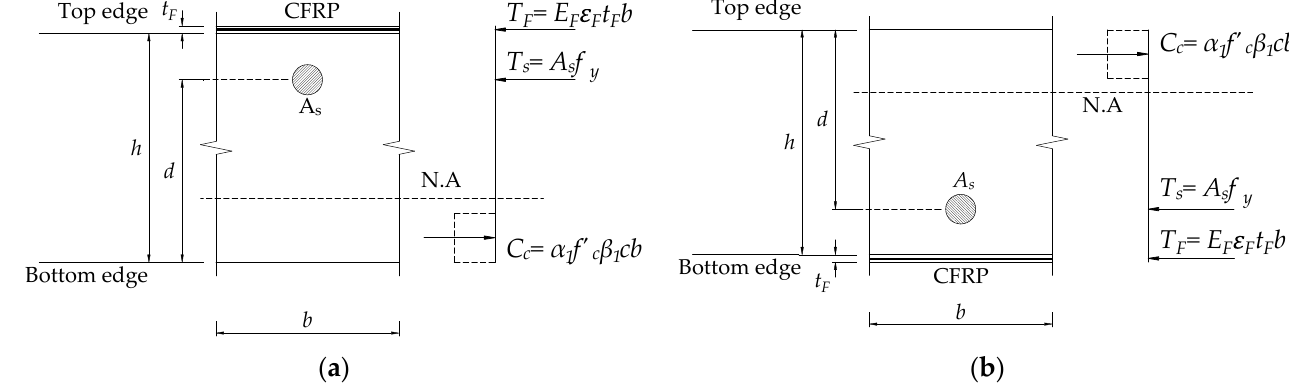
Figure 5. The CFRP strengthened sections are subjected to ( a ) negative moment and ( b ) positive moment. Table 3. Calculation of the existing RC slab.